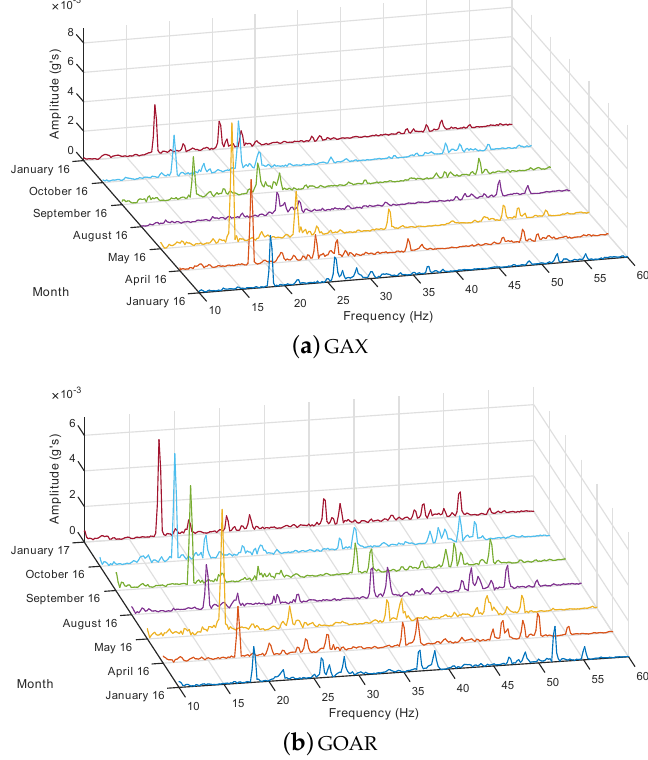
Figure 7. January 2016–January 2017. Evolution of shaft-frequencies at super-synchronous